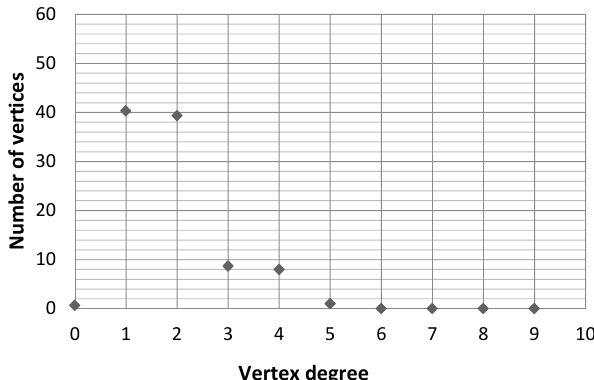
Figure 13. The vertex degree distribution after removing STW and BGC nodes and two of the fifth degree nodes (averaged data).